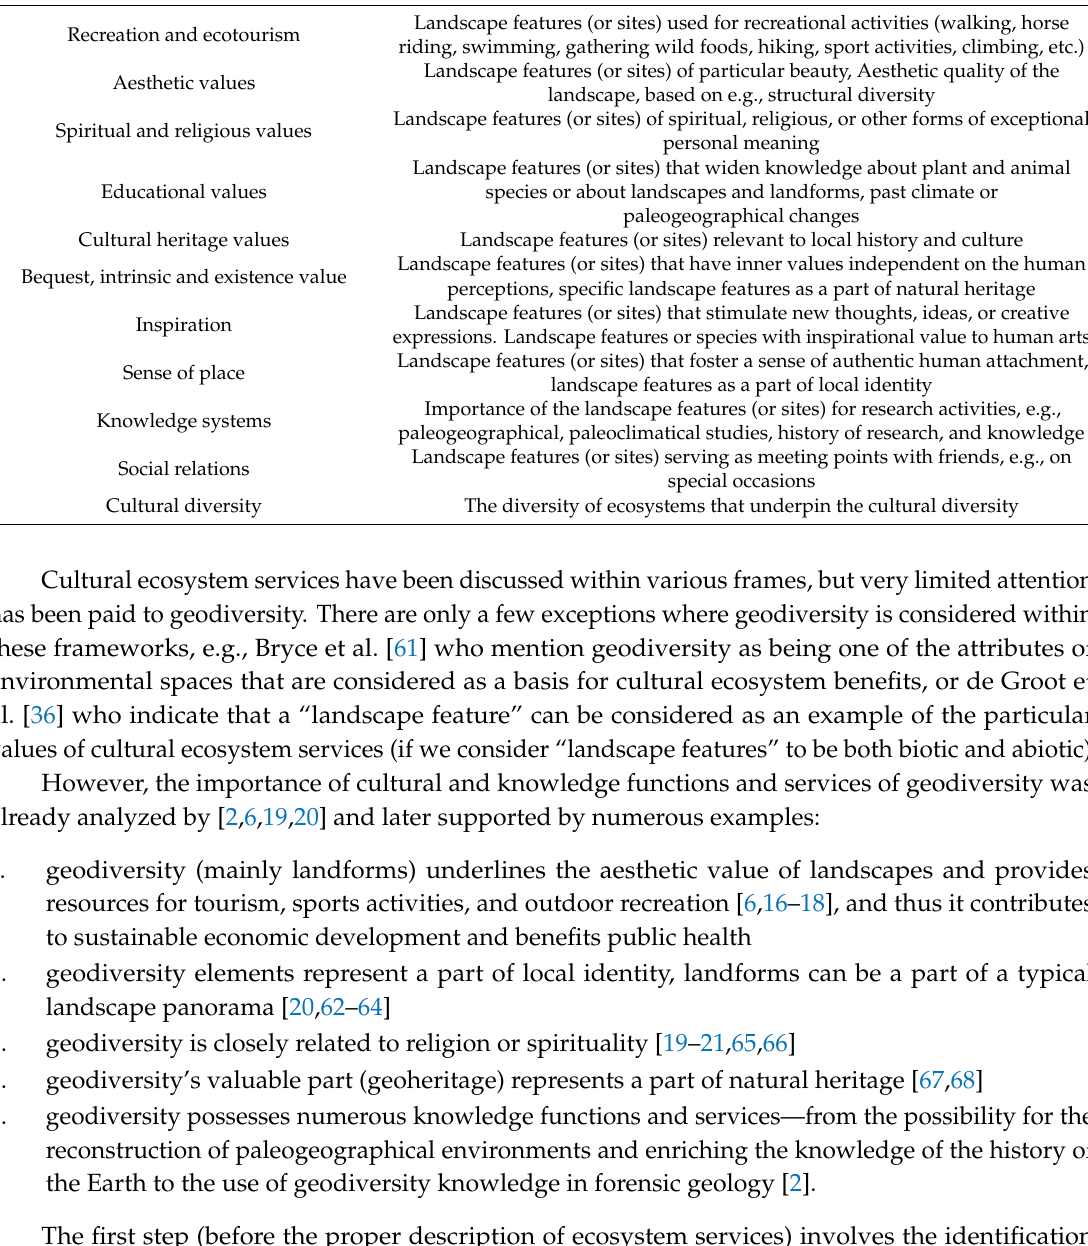
Table 1. Cultural ecosystem services and their subcategories (adapted from [25,36,55]). Values Examples Recreation and